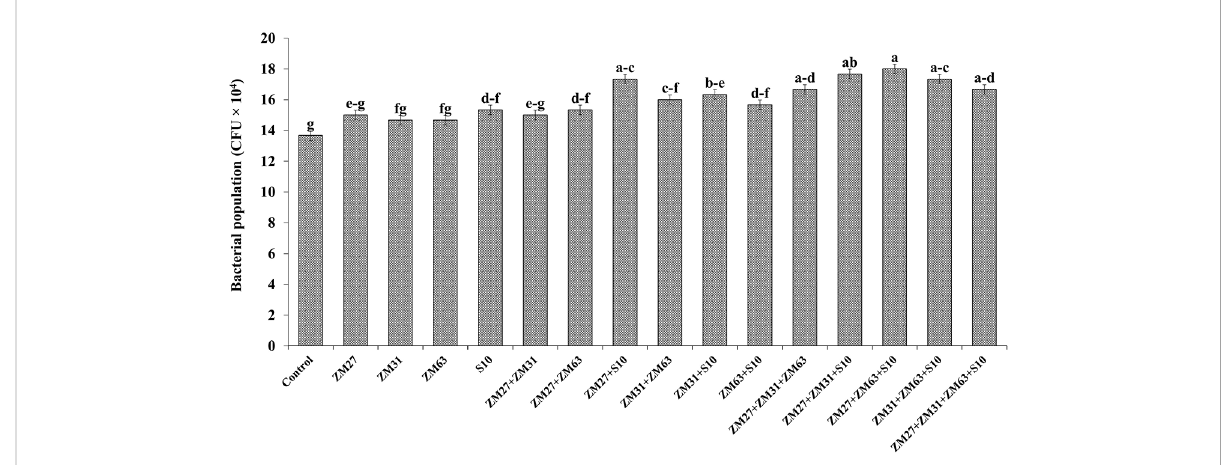
FIGURE 3 Effect of PGPR inoculation on microbial population in maize rhizosphere in the pot trial. The bars with different letters are signi fi cantly different at p ≤ 0.05.